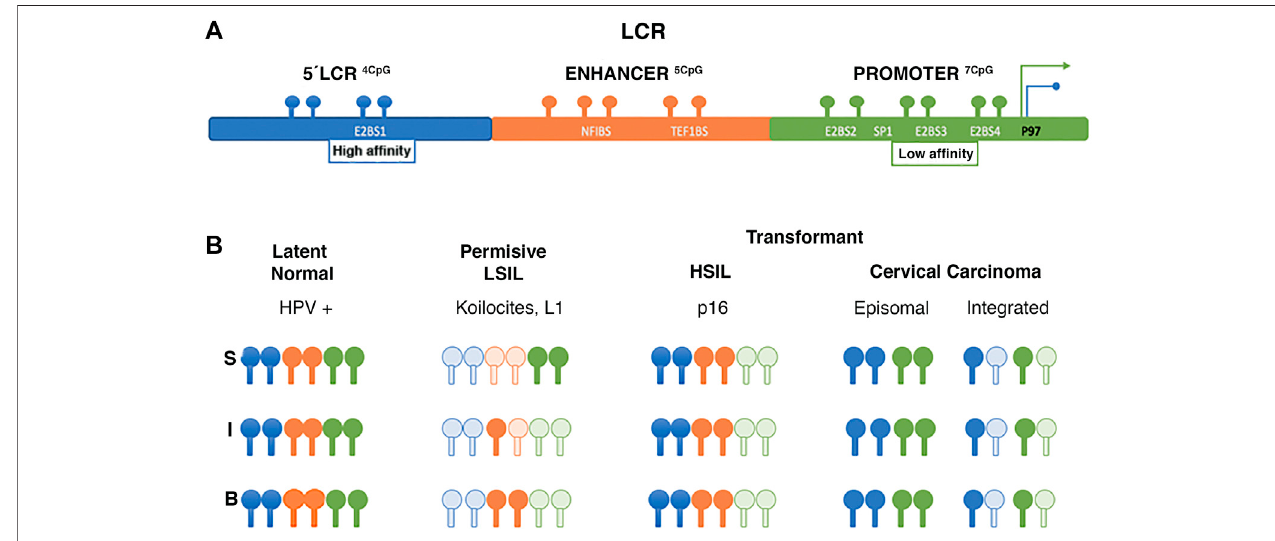
FIGURE 3 | Changes of methylation in LCR of HPV 16. (A) LCR region binding sites. (B) Schematic illustrating LCR methylation changes of HPV 16 isolated from different epithelial layers. The letters “ S, ” “ I, ” and “ B ” refer to super fi cial, intermediate, and basal layers respectively, and at different stages of viral infection and transformation. Dark spots show methylated CpG clear spots show unmethylated CpG. Data from Vinokurova and von Knebel Doeberitz 2011, Chaiwongkot et al.